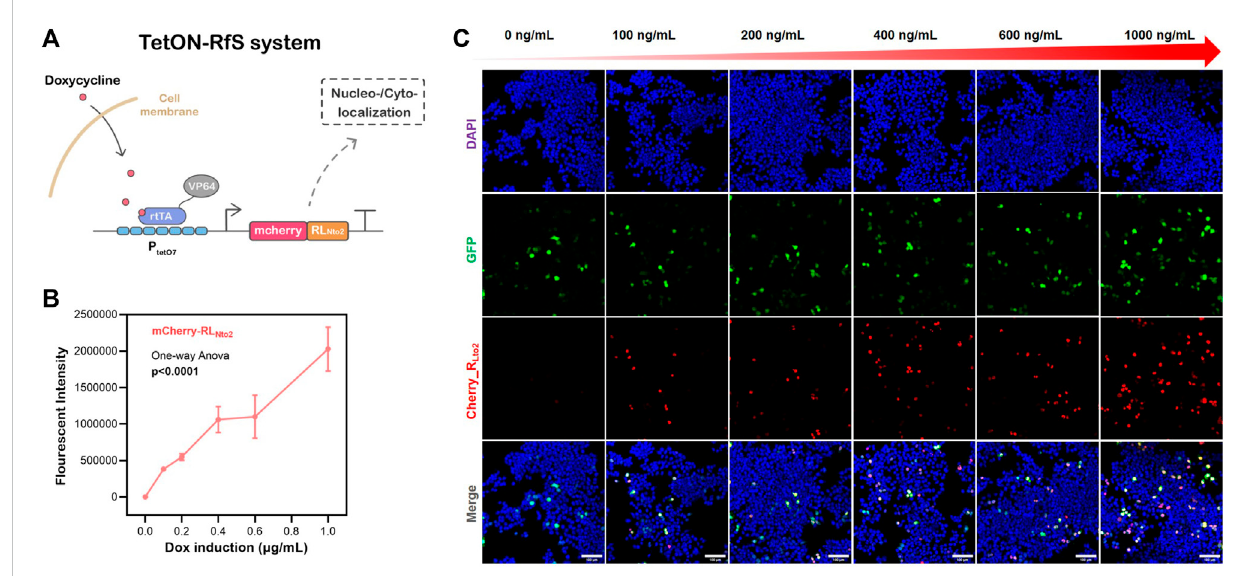
FIGURE 3 Dose-dependent nuclei-targeted Tet-On-RL Nto2 system mediated by doxycycline. (A) schematic diagram of the Tet-On-Rfs system. (B) Total Intensity, which represents the gross expression of mcherry_RL Nto2. Data are presented as mean values ±SD for n = 3 independent experiments. (C) Activation of the Tet-On-Rfs system. Transfected cells are indicated by GFP (green), and the localization of RL Nto2 is labeled by tandem mCherry (Red); Scalebars = 100 μ